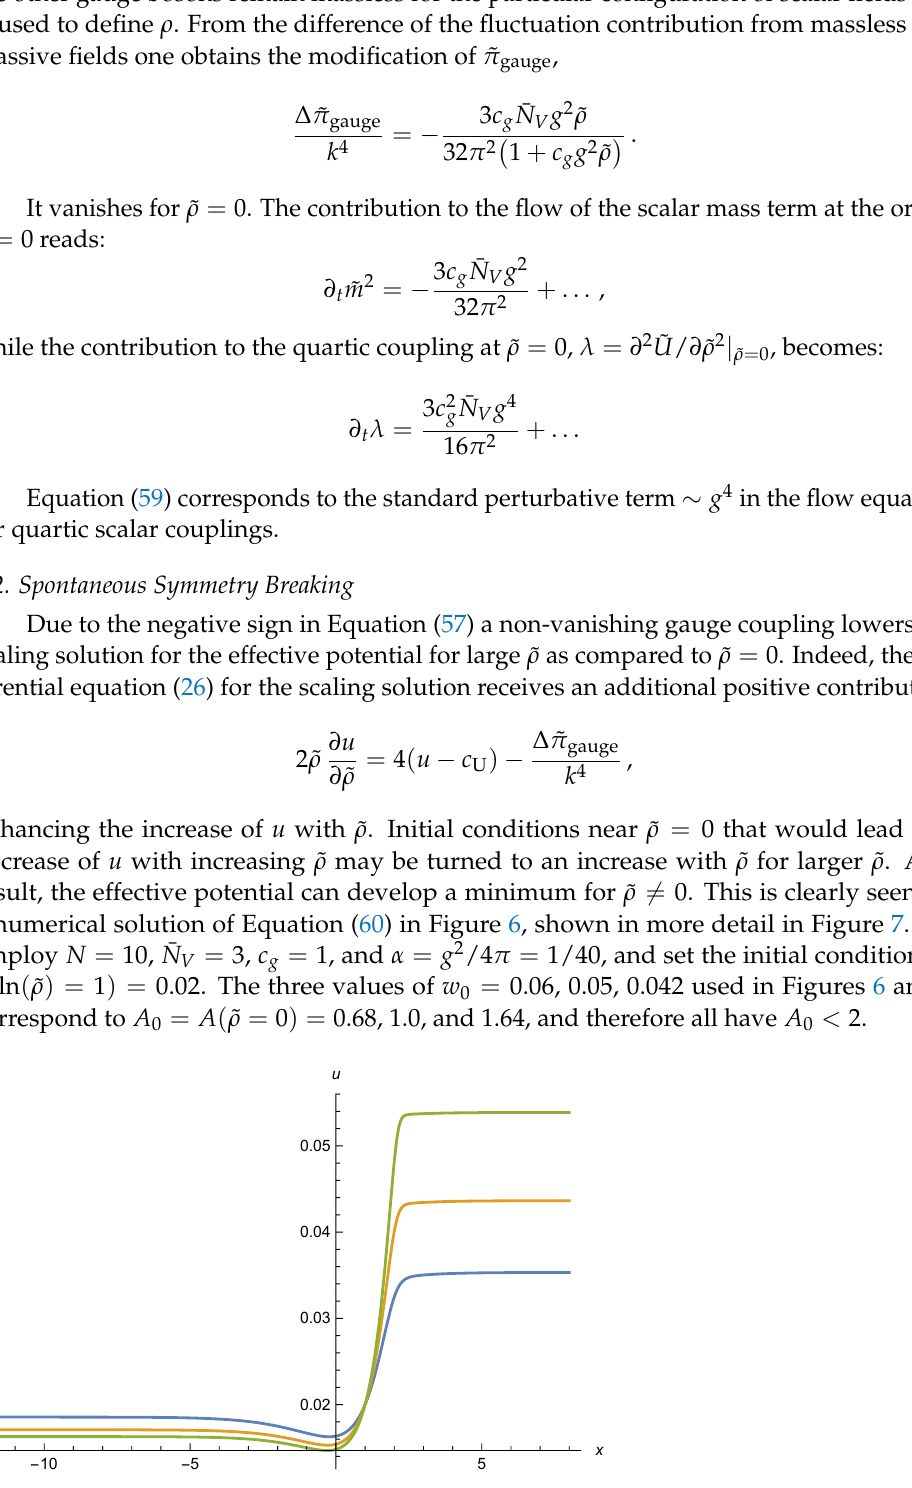
Figure 6. Effective potential u ( x ) as function of x = ln ( ˜ ρ ) for three values of w 0 . The highest curve on the right (green) is for w 0 = 0.06, the middle curve (orange) for w 0 = 0.05, and the lowest curve (blue) for w 0 = 0.042. Initial values are set by U ( x = 1 ) = 0.02. Parameters are N = 10, ¯ N V = 3, and α = g 2 /4 π =